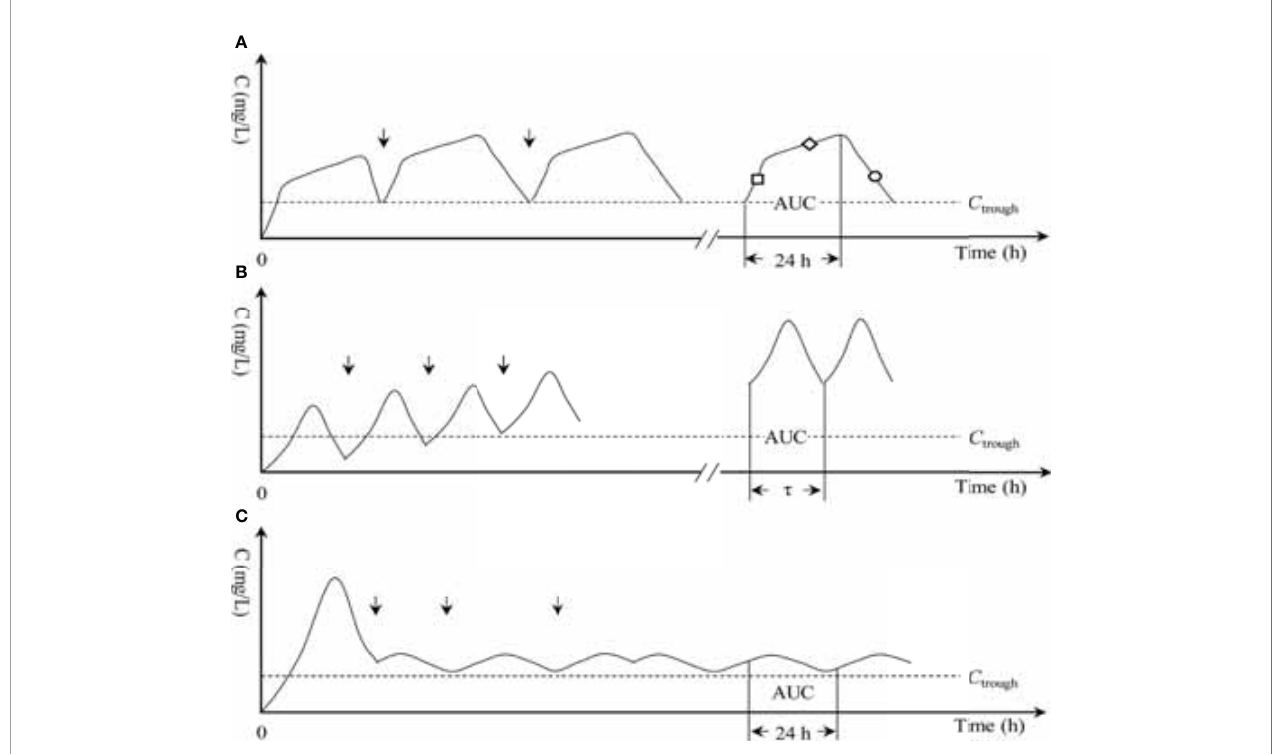
FIGURE 1 | Three infusion modes of vancomycin. (A) OTSI, optimal two-step infusion; “ □ ” , loading-rate rapid infusion (LRRI) phase in OTSI mode; “ ◇ ” , low-rate continuous infusion (LRCI) phase in OTSI mode; “ ○ ” , elimination phase in OTSI mode. (B) II, intermittent infusion; t , dosing interval; and (C) CI, continuous infusion. “ ↓ ” , start of the dose; AUC, area under the curve; C , drug concentration; C trough , trough